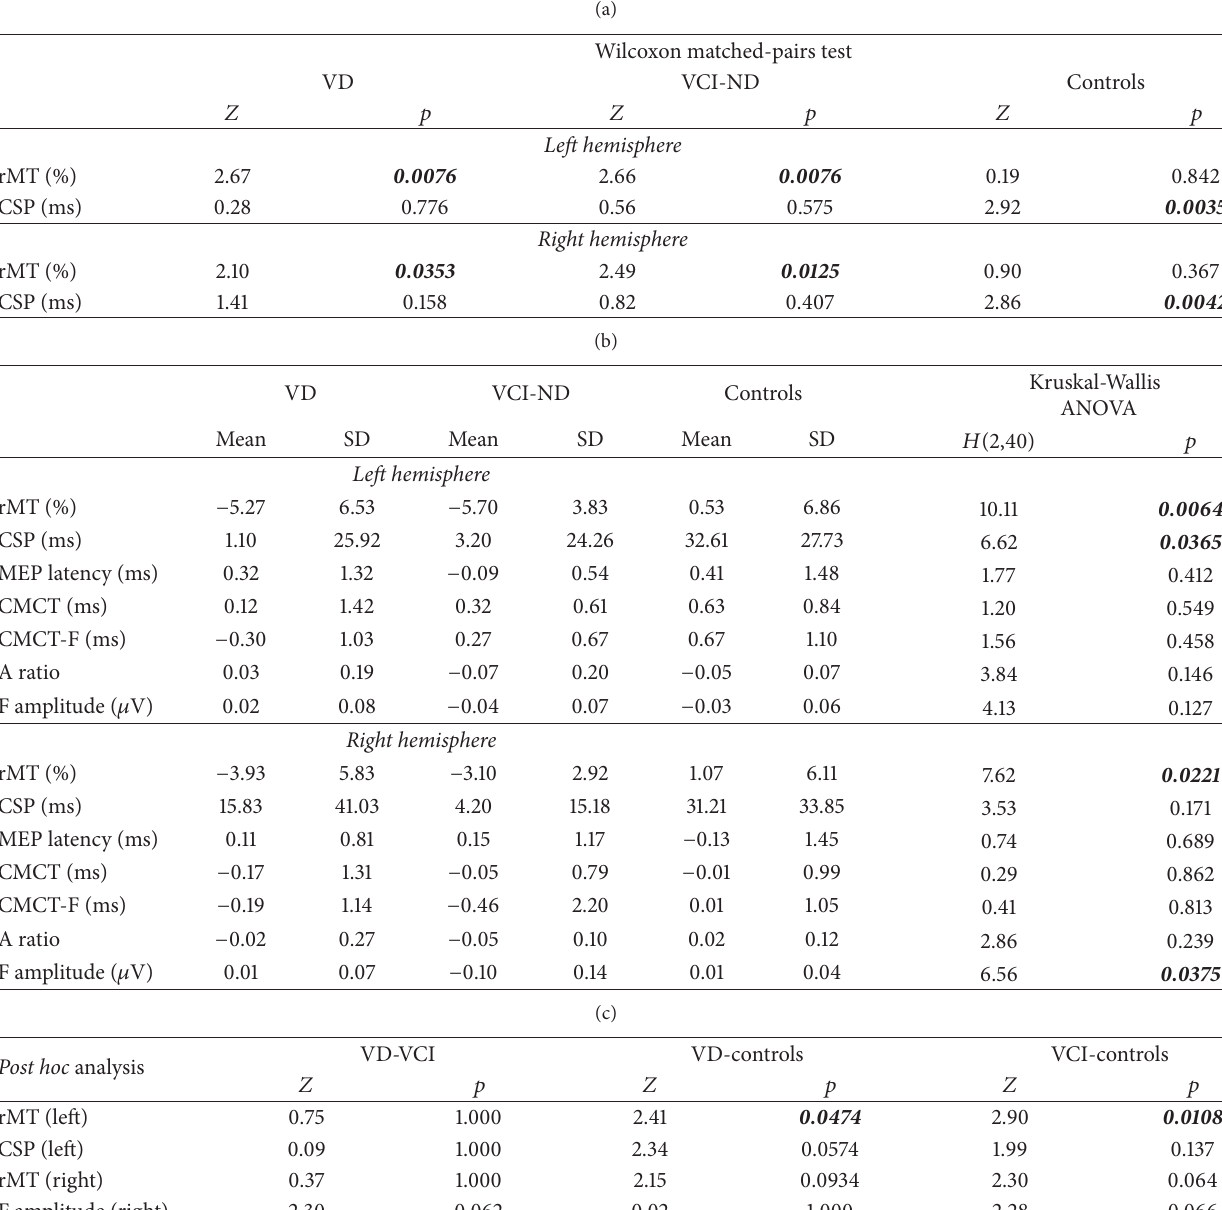
Table 4: Comparison of clinical and neuropsychological features of the three groups between baseline ( 𝑡 0 ) and follow-up ( 𝑡 1 ); differences are computed as 𝑡 1 − 𝑡 0